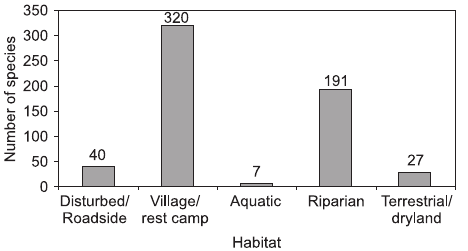
Fig. 3: Number of alien plant species per habitat type (some species may occur in more than one habitat